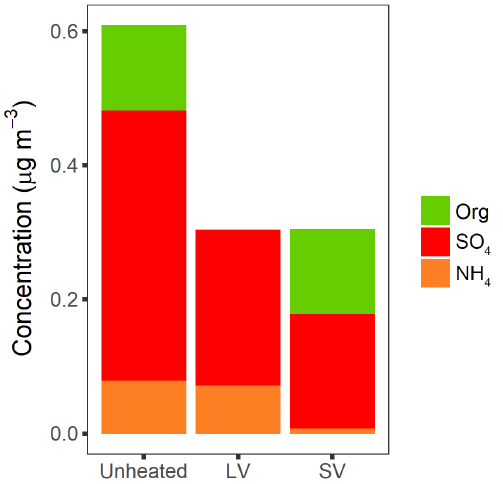
Figure 8. Contribution of sulfates, ammonium and non-refractory organic compounds to the total, semi-volatile and low-volatility fractions of marine aerosol at Cape